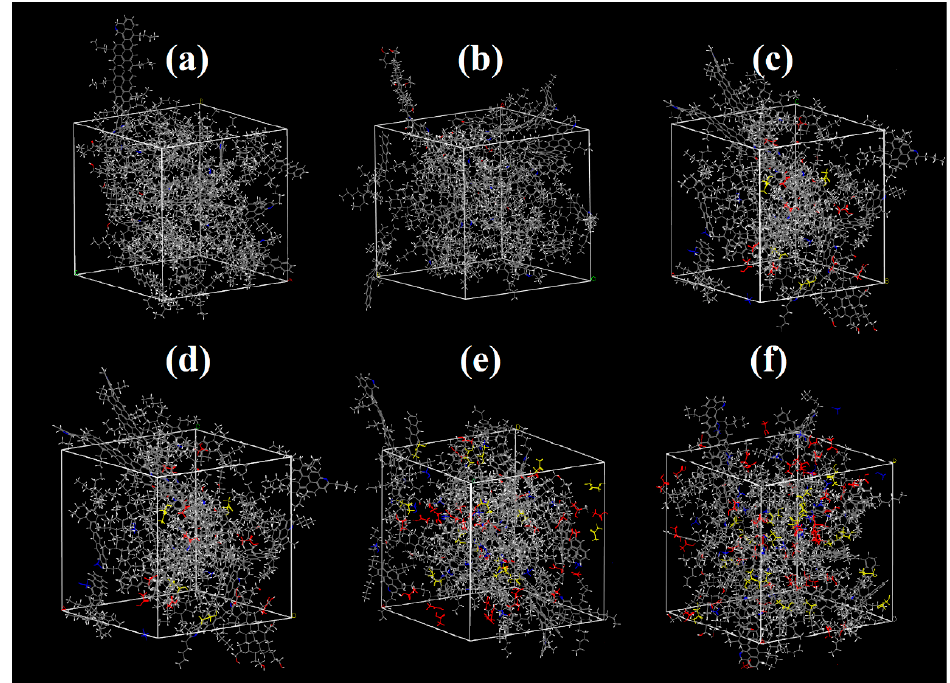
Figure 2. Models of asphalt systems: ( a ) asphalt; ( b ) aged asphalt; ( c ) 5% BRAA; ( d ) 10% BRAA; ( e ) 15% BRAA; ( f ) 20% BRAA.